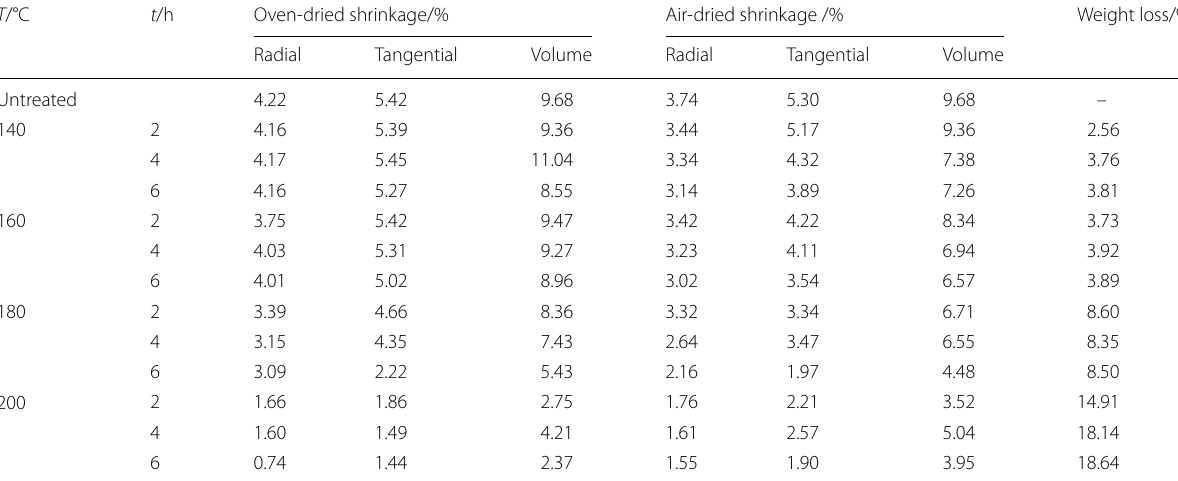
Table 5 The dry shrinkage and weight loss of untreated and oil heat-treated bamboo samples T /°C t /h